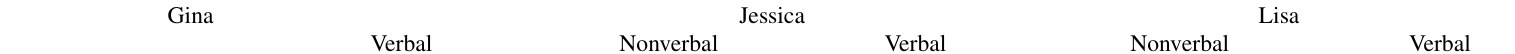
TABLE I. Transcript of a segment of the problem-solving session. The columns separate nonverbal and verbal behaviors for Gina, Jessica, and Lisa. The numbers denote the order of